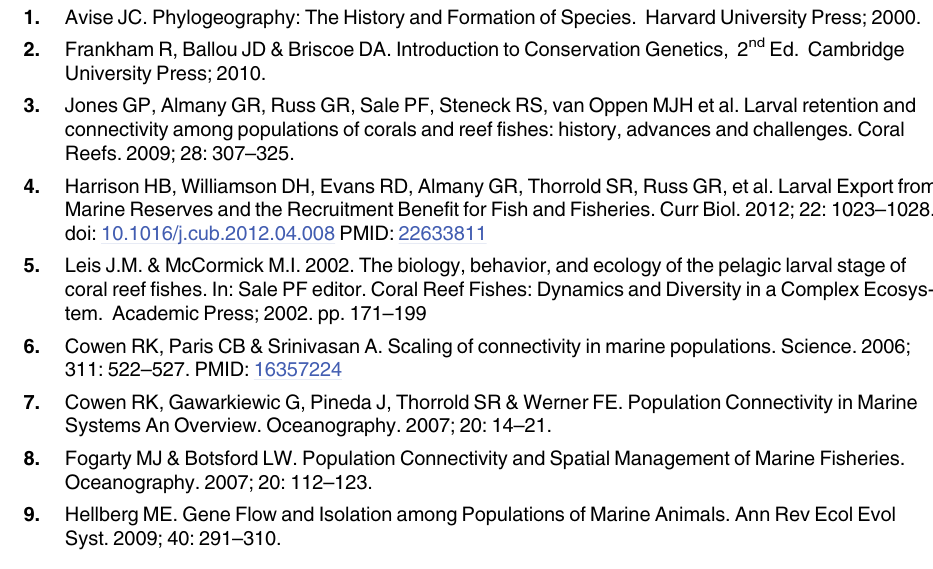
S4 Table. Pairwise F comparisons for the 7 sampled populations of Alticus arnoldorum , ST